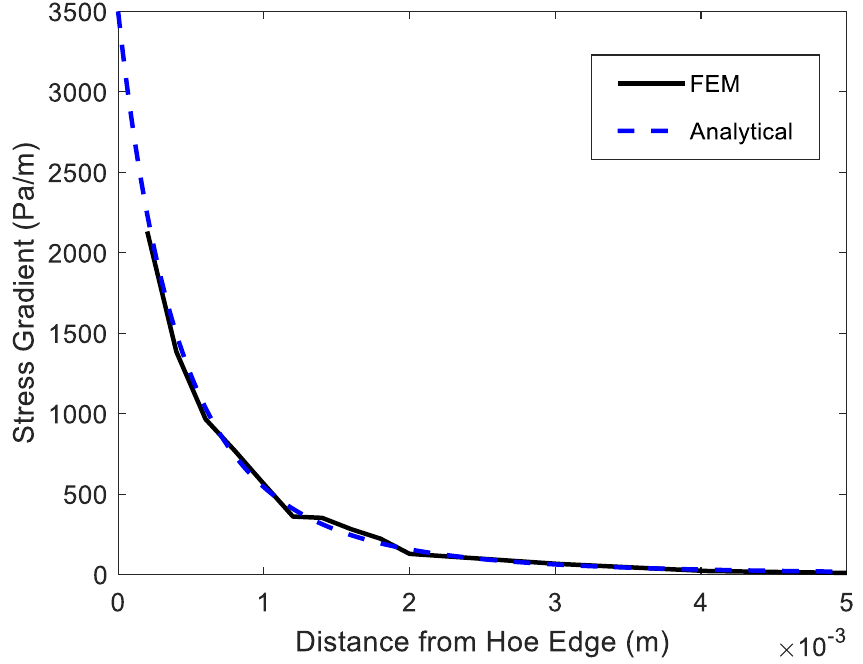
Figure 5. Stress gradient from the edge of a hole of an infinite plate.